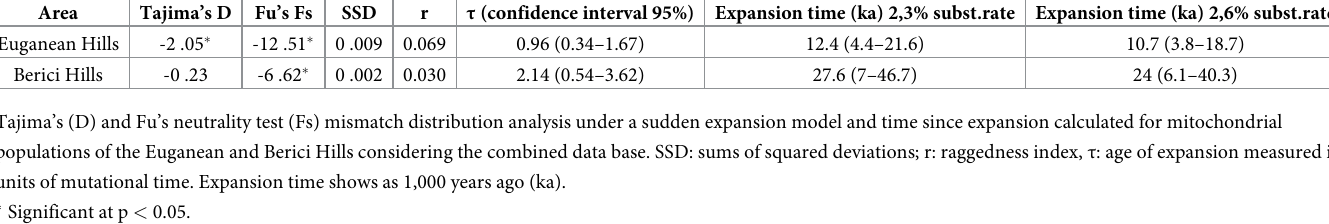
Table 3. Statistic summary of the past demographic events analysis of Barbitistes vicetinus populations. Area